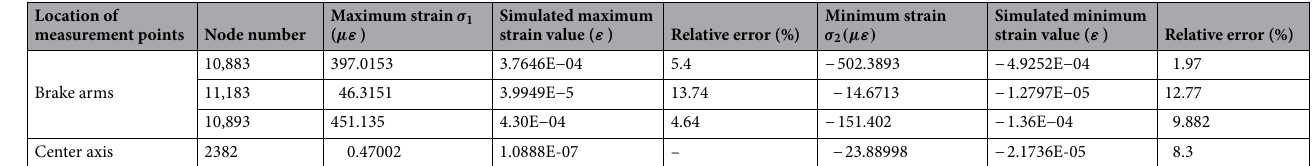
Table 4. Comparisons between simulation results and test